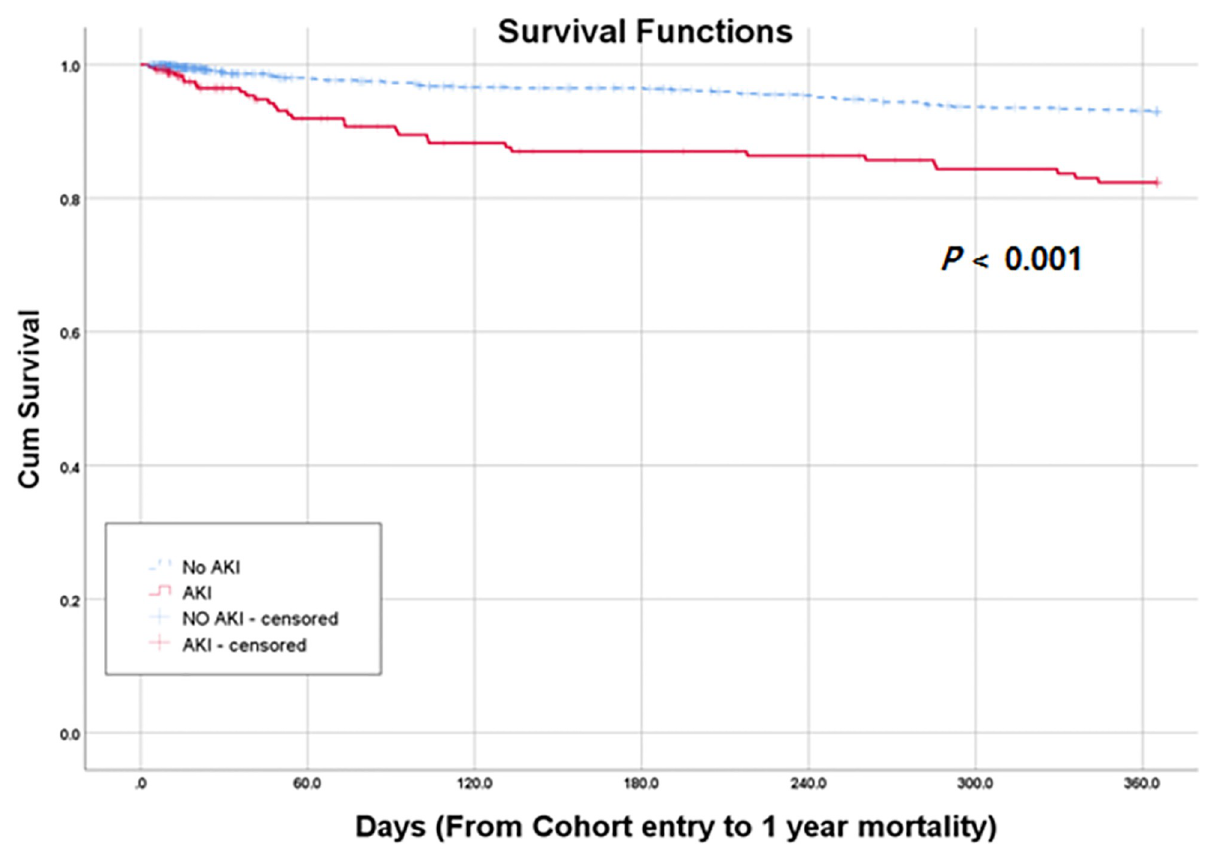
Fig 3. Kaplan survival analysis of survival associated with the presence of AKI in HD patients.